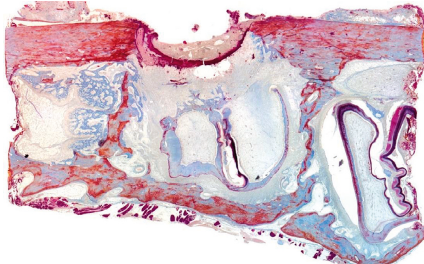
Figure 4: Histotopogram of the rabbit’s mandible cross section 2 weeks after the formation of a bone defect and introduction of a suspension of calcium hydroxide with nanodispersed cerium dioxide.